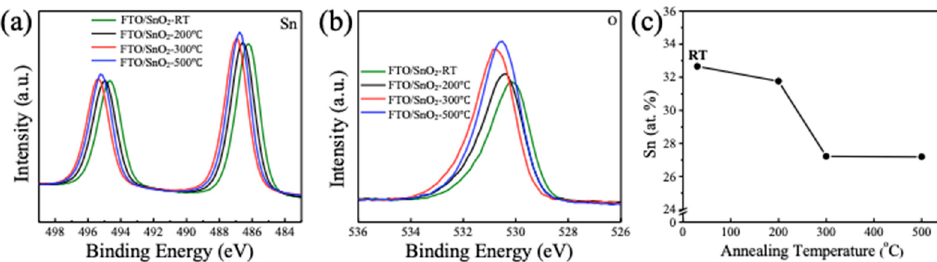
Figure 4. X-ray photoelectron spectroscopy spectra of FTO/SnO 2 samples annealed at various temperatures for ( a ) Sn, ( b ) O, and ( c ) extracted atomic ratio of Sn.